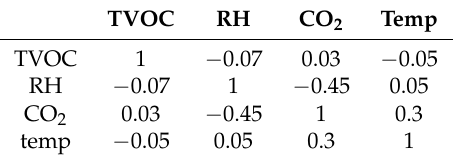
Table 1. Correlation matrix of indoor air quality (IAQ)